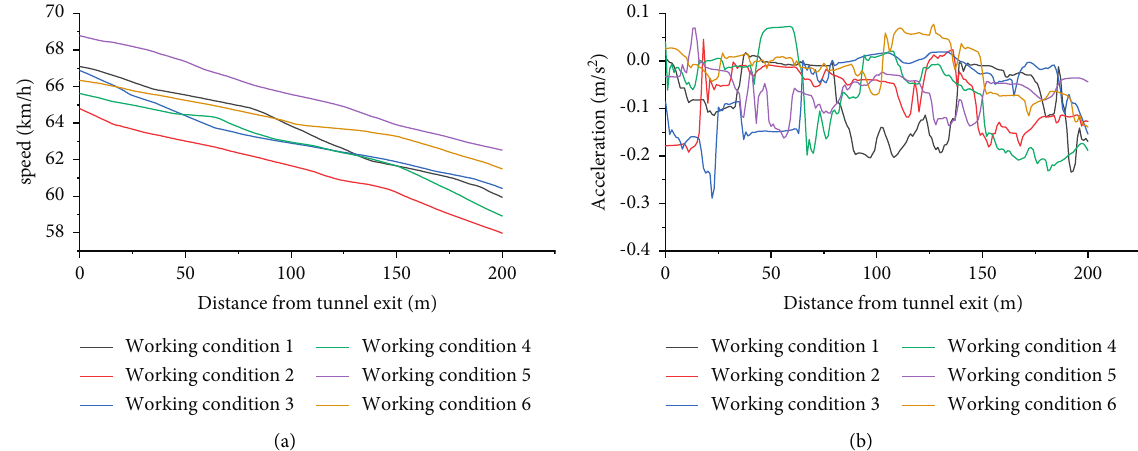
Figure 9: Vehicle speed and acceleration curves within 200m after the tunnel exit in the third service level. (a) Speed curve (b) Acceleration